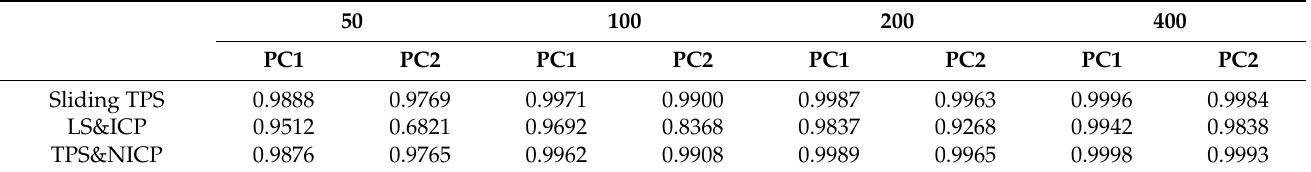
Table 9. Pearson correlations (all p < 0.01, parametric test) among PC scores from each semilandmark- ing density and the maximum